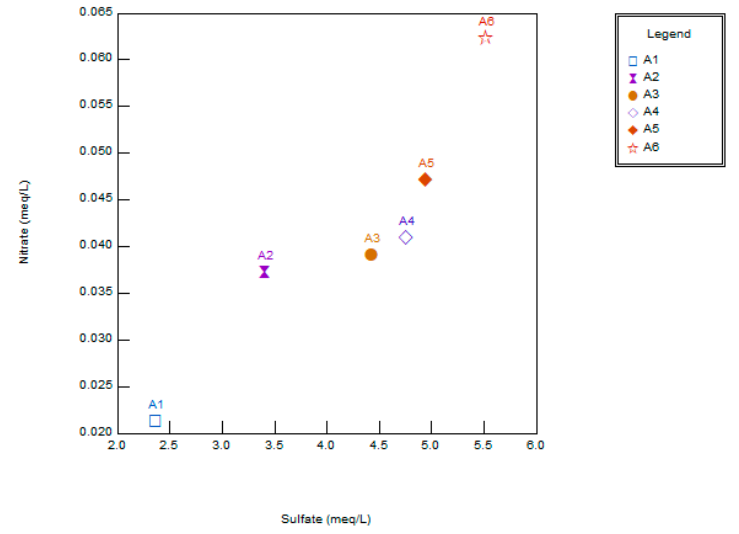
Figure 6. Scatter plot showing relationship between NO 3– and SO 42– .